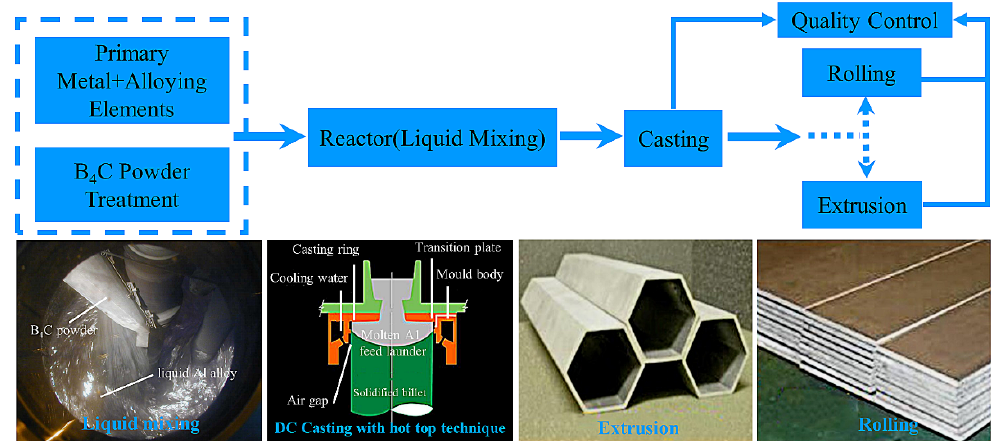
Figure 9. Boralcan production process route